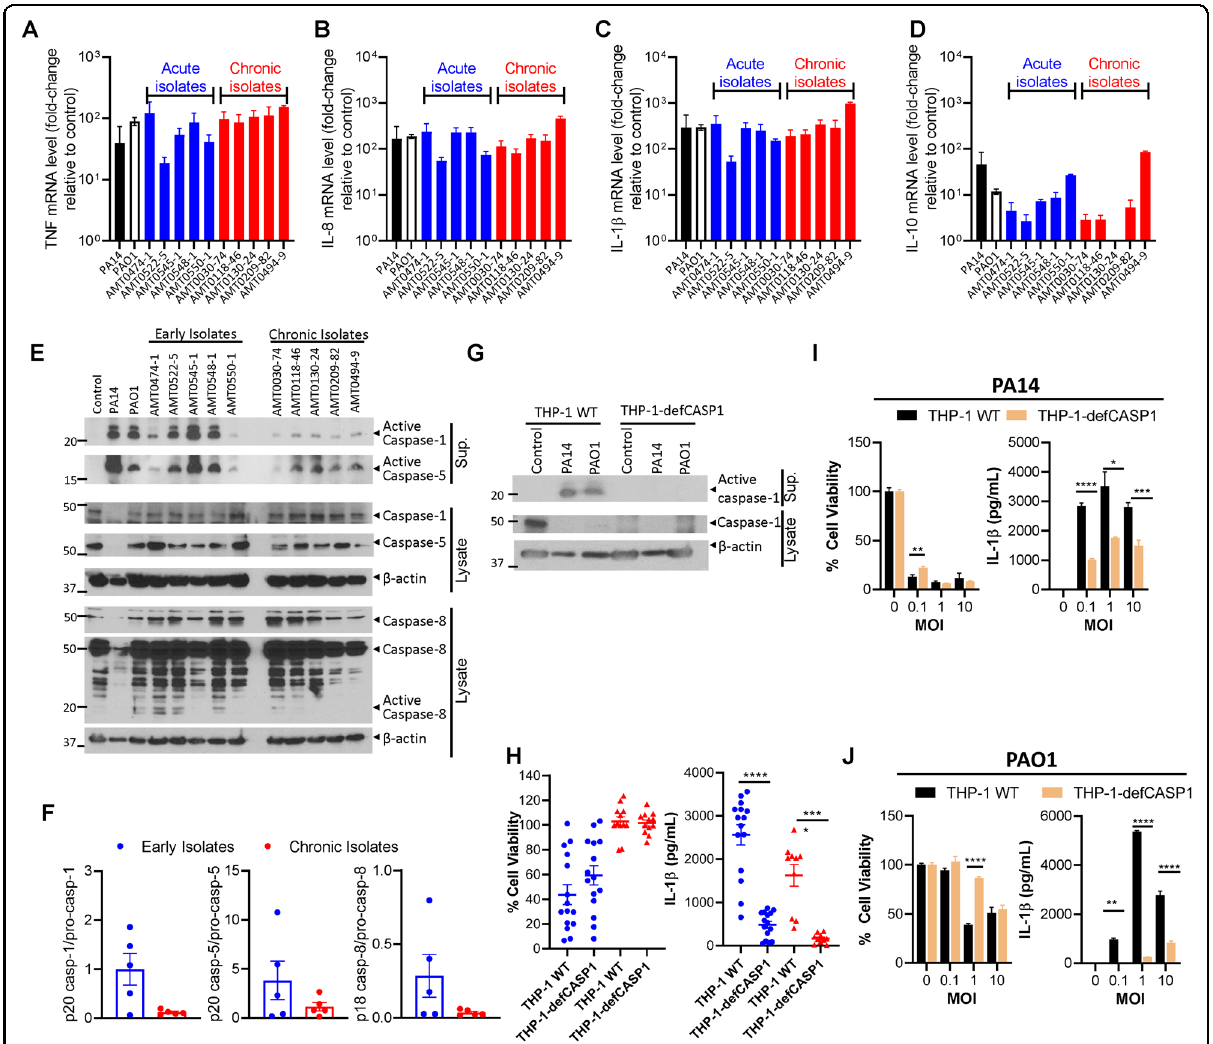
Fig. 2 Cell death induced by P. aeruginosa , but not IL-1 β expression, is independent of caspase-1. THP-1 macrophages were seeded at 500,000 cells/well in a 24-well plate. At 1 h postinfection (1 MOI) with the indicated acute and chronic isolates of P. aeruginosa from CF patients. RNA was extracted and cDNA was synthesized. qPCR was conducted on samples targeting genes for various cytokines, and mRNA levels were normalized to β -actin ( A – D ). THP-1 macrophages were seeded at 500,000 cells/well in a 24-well plate. At 3 h postinfection (1 MOI) with the indicated acute and chronic isolates of P. aeruginosa from CF patients, western blotting was performed on cell supernatants or extracts using speci fi c antibodies shown in fi gure ( E ). Densitometric analysis of western blots shown in panel E was conducted ( F ). THP-1 WT and THP1-defCASP1 were infected with PA14 or PAO1 (1 MOI) and western blotting was performed on supernatants or cell extracts at 3 h postinfection ( G ). THP-1 WT and THP1-defCASP1 were infected with early and chronic P. aeruginosa CF isolates (1 MOI) in experimental triplicates. Cell viability was evaluated at 3 h postinfection by neutral red assay, and IL-1 β production was measured in supernatants by ELISA ( H ). Mann – Whitney U tests were conducted. THP-1 WT and THP-1-defCASP1 macrophages were infected with PA14 or PAO1 P. aeruginosa , and cell viability and cytokine production were measured as mentioned above ( I , J ). Mean values were compared by Student ’ s t -tests, except for measured IL-1 β for PA14 at 1 MOI and PAO1 at 0.1 MOI, where Welch ’ s t -tests were used. Mean ± SD of triplicates of a representative, or a pool of >3 experiments are shown. (* P < 0.05, ** P < 0.01, *** P < 0.001, **** P <